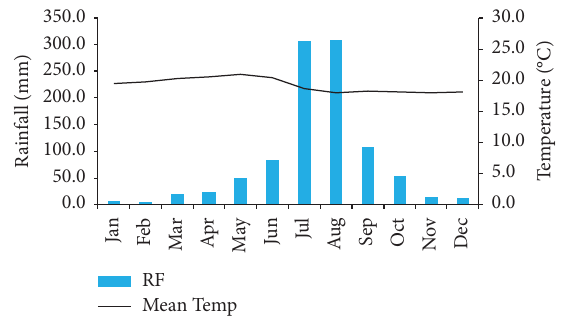
Figure 1: Monthly average rainfall and temperature distribution of Lay Gayint in the 2019 cropping season.